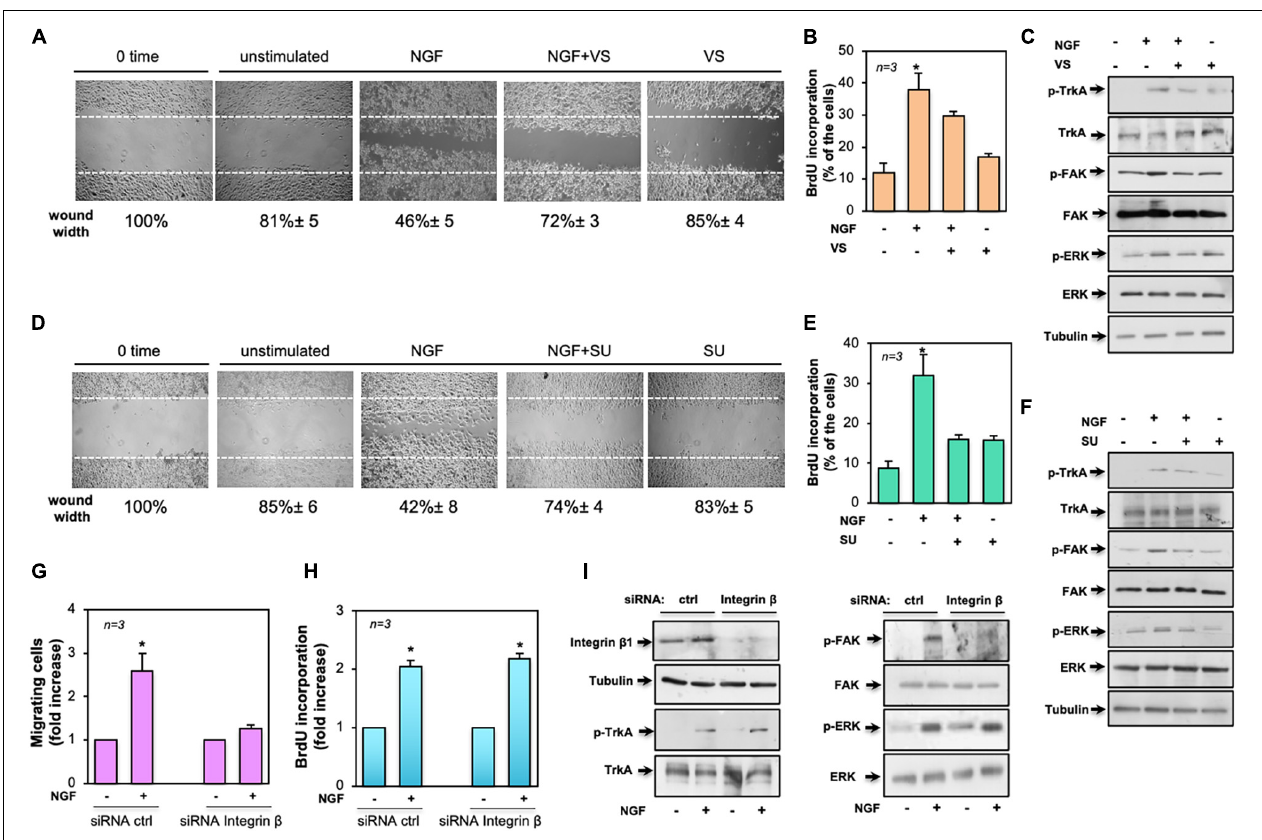
FIGURE 7 | Role of focal adhesion kinase (FAK), Src, and β 1-integrin in the biological effects elicited by neurotrophin β -nerve growth factor (NGF) treatment of MDA-MB-231 cells. In (A–F) , quiescent MDA-MB-231 cells were used. In (A–C) , the FAK inhibitor VS-6063 (VS) was used at 10 µ M. In (D–F) , the Src inhibitor SU6656 (SU) was used at 5 µ M. In (A–I) , NGF was used at 100 ng/ml. (A,D) Cells were wounded and left unstimulated or stimulated with NGF in the absence or presence of the indicated compounds. Phase-contrast images are representative of three different experiments, each in duplicate. The wound area was calculated using Leica Suite software and data are reported below each image . Data are expressed as the percentage of decrease in wound width over the control cells (analyzed at time 0). (B,E) Cells were left untreated or treated for 18 h with the indicated compounds. After in vivo pulse with 100 µ M BrdU, incorporation of BrdU by the cells was analyzed by immunofluorescence (IF) and expressed as the percentage of total cells. (C,F) Cells were left unchallenged or challenged for 15 min with NGF in the absence or presence of the indicated compounds. Lysate proteins were analyzed by Western blot (WB) using the antibodies against the indicated proteins. (G–I) MDA-MB-231 cells were transfected with β 1-integrin or control (ctrl) siRNA in the presence (G,H) or absence (I) of eGFP-cDNA to help in the identification of transfected cells. (G) Quiescent cells were left unstimulated or stimulated with NGF for 7 h and used for the migration assay. Migrated cells were scored using a fluorescent microscope and the data expressed as the relative increase in the number of migrating cells. Data from several independent experiments were collected and analyzed. (H) Quiescent cells were left untreated or treated with NGF for 18 h. After in vivo pulse with 100 µ M BrdU, the DNA synthesis was analyzed by IF and calculated using the formula: percentage of BrdU-positive cells = (No. of transfected BrdU-positive cells/No. of transfected cells) × 100. Data are presented as the fold increase over the basal level. In (G,H) , for each plasmid, the data are derived from at least 500 transfected cells. The results of three independent experiments have been averaged. Means and SEM are shown. n represents the number of experiments. (I) Transfected cells were left unstimulated or stimulated with NGF for 15 min and lysate proteins were analyzed by WB using the antibodies against the indicated proteins. Abbreviations used in (C,F,E) : p-TrkA